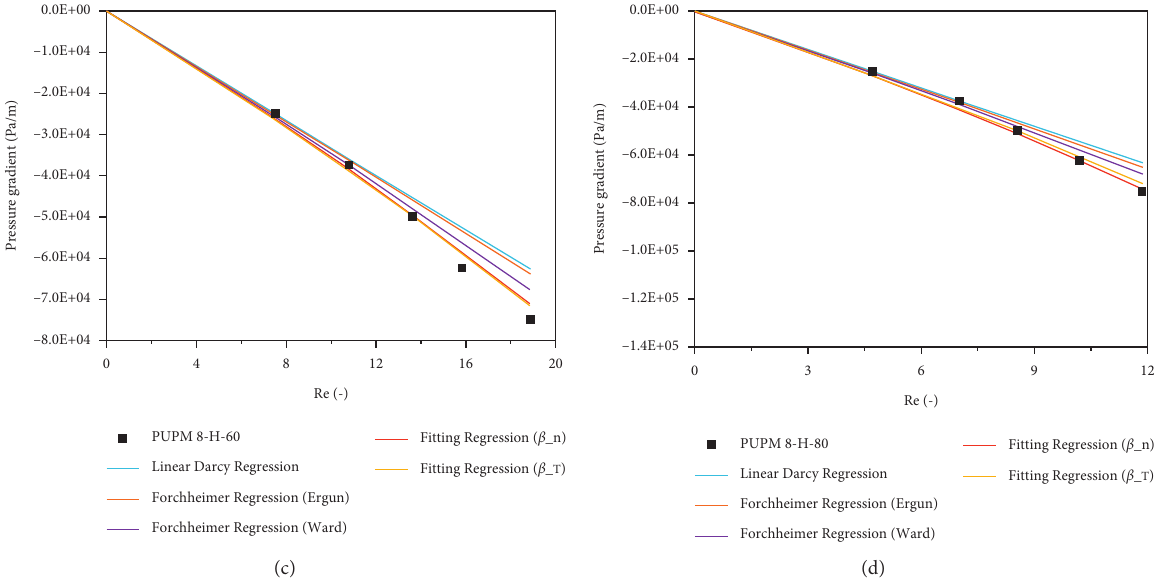
Figure 11: Modified Forchheimer’s regressions and previous regressions for PUPM 8-H at different clogging periods (minutes): (a) 20; (b) 40; (c) 60; and (d)